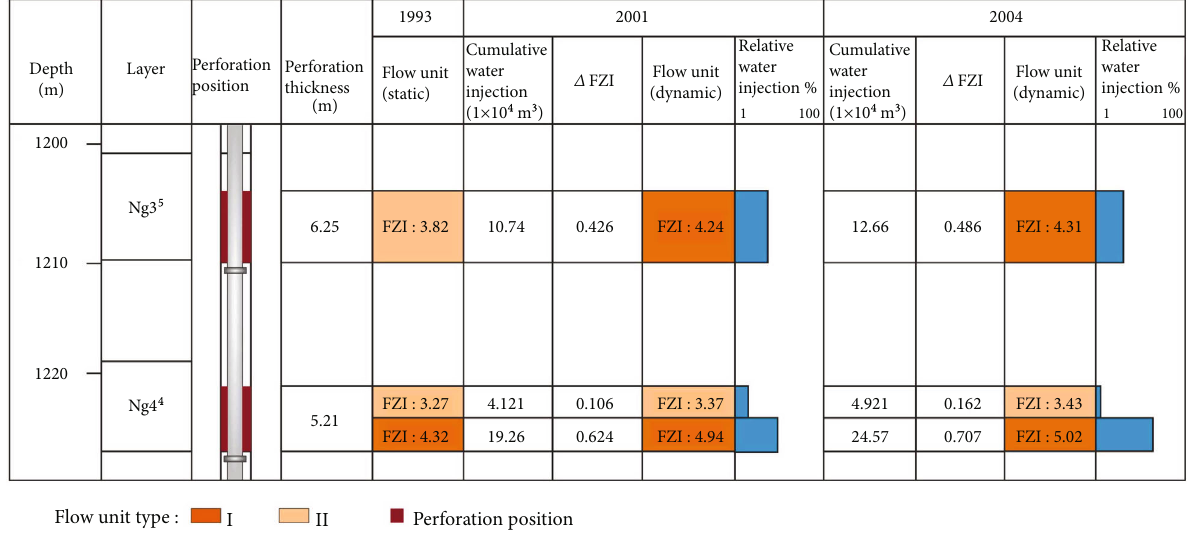
Figure 10: Test data of water absorption pro fi le. Table 3: Division of development period of the study